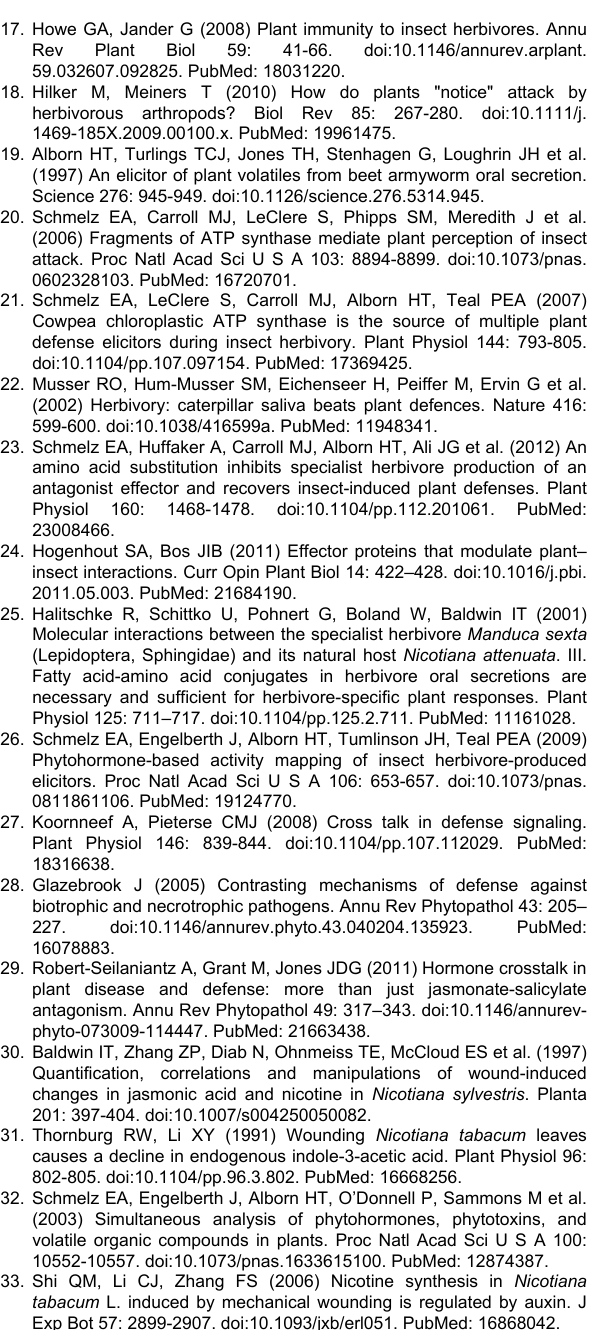
tabacum L. induced by mechanical wounding is regulated by auxin. J Exp Bot 57: 2899-2907. doi:10.1093/jxb/erl051. PubMed: 16868042.